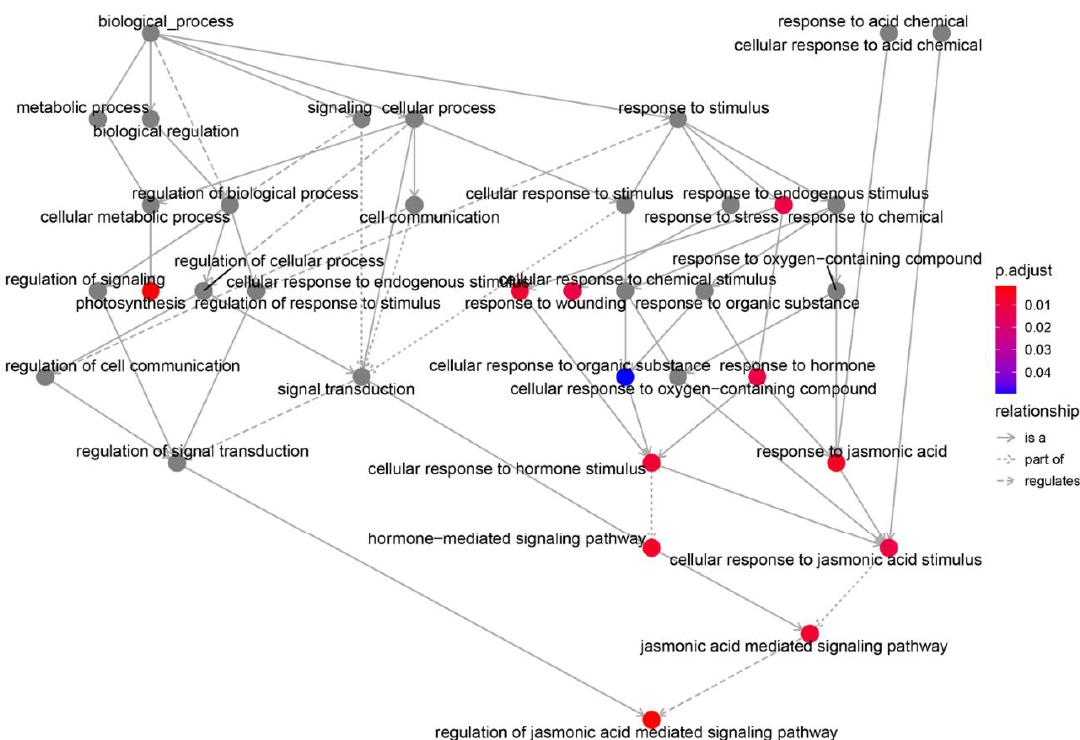
Figure 6. Connect network of those GO terms in biological processes Where the relations between the GO terms are represented as edges: is a (is a subtype of); part of (part of whole); regulates (the former regulates the latter).